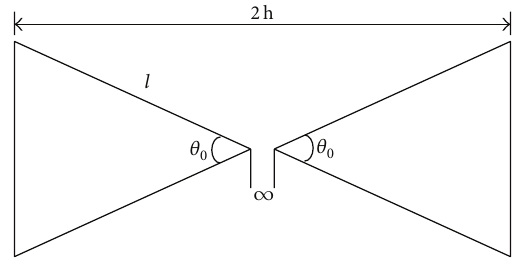
Figure 3: The structure of the bow-tie antenna.